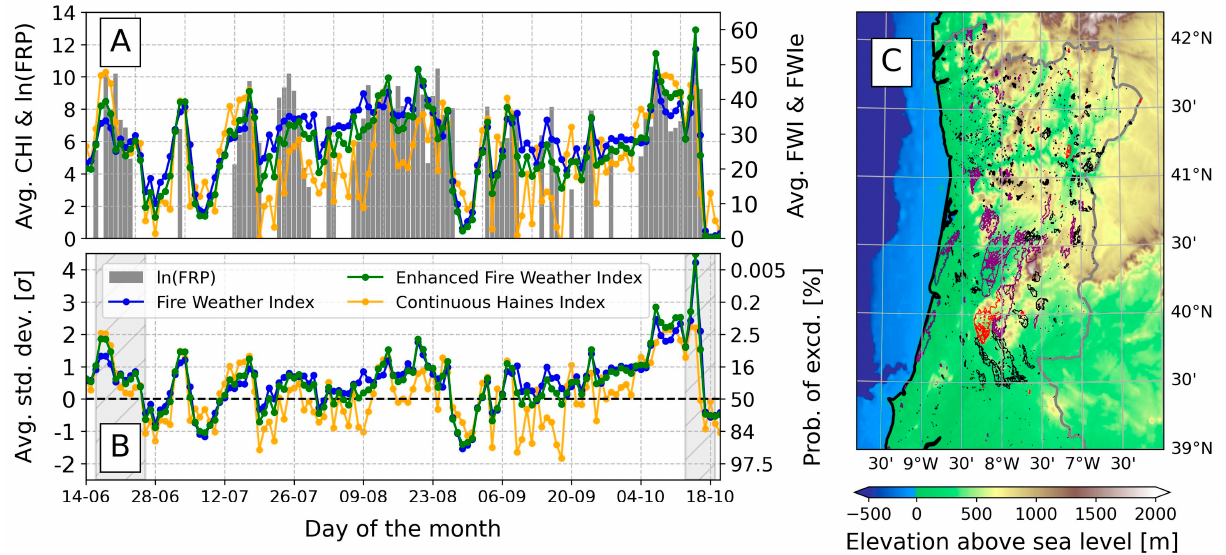
Figure 7. Comparison of the evolution of the CHI (yellow), FWI (blue), and the resulting FWIe (green) during the Portuguese 2017 fire season. ( A ) shows the daily average of each variable spatially averaged over the affected areas in Portugal and the natural logarithm of the daily FRP sum in grey bars. ( B ) shows the exceedance over (or under) the mean value of each variable in the number of standard deviations, and the approximate probability of exceedance can be seen on the right. Shaded grey areas represent the two time periods of the case studies mentioned above and are shown in ( C ) with the respective affected areas in different colors (red for 16 − 25 June and purple for 13 − 18 October). More details can be found in the Methods